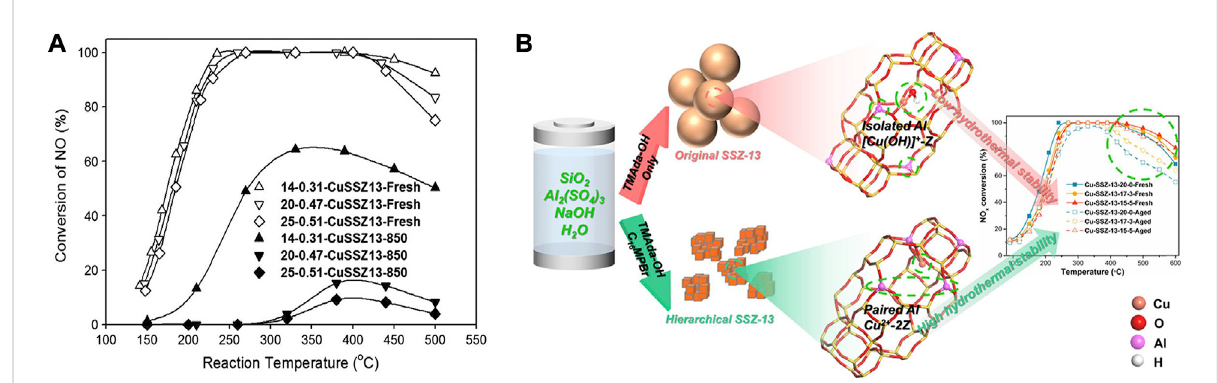
FIGURE 4 TheeffectsofzeoliteframeworkcompositionofCu-SSZ-13catalystsonCu 2+ activesitesandSCRperformance. (A) ThedeNO x performanceof Cu-SSZ-13catalystswithdifferentSi/Alratiosbeforeandafterhydrothermalagingat850 ° C.ReproducedwithpermissionKimetal.(2014),Copyright 2014, Elsevier Publishers. (B) Collaboration of TMAda-OH and C 16 MPBr templates induced more paired Al and Z 2 Cu sites contributing to the improved hydrothermal stability. Reproduced with permission Chen Z. X. et al. (2022), Copyright 2022, Elsevier